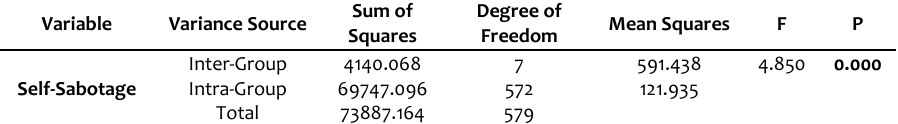
Sum of Degree of Mean Squares F P Squares Freedom